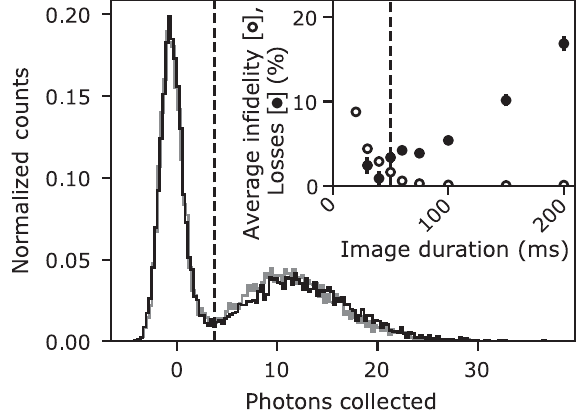
FIG. 4. Number of photons collected relative to camera back- ground in successive images of a single tweezer (gray trace is first image, black is second). Two peaks are clearly visible, corre- sponding to zero and one atom in the tweezer. By applying a threshold (dashed vertical line) at 3.7 photons, we can distinguish an occupied tweezer from an unoccupied tweezer with 98.4(1)% average fidelity. We observe 2.4(4)% atom loss between the two images. Inset: Infidelity (empty circles), losses (black points) versus imaging duration. Choosing an imaging duration involves a trade-off between imaging long enough to collect a sufficient number of photons to resolve the presence of an atom and the loss associated with scattering many photons. Dashed line denotes where we typically operate in this